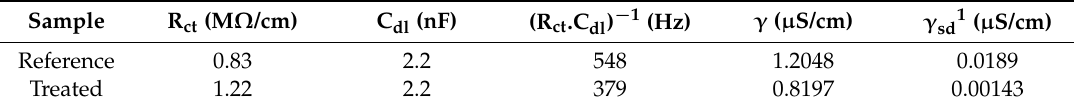
Figure 6. The impedance analysis scheme. Table 2. Impedance spectroscopy measurement: Specific conductances of the water samples .